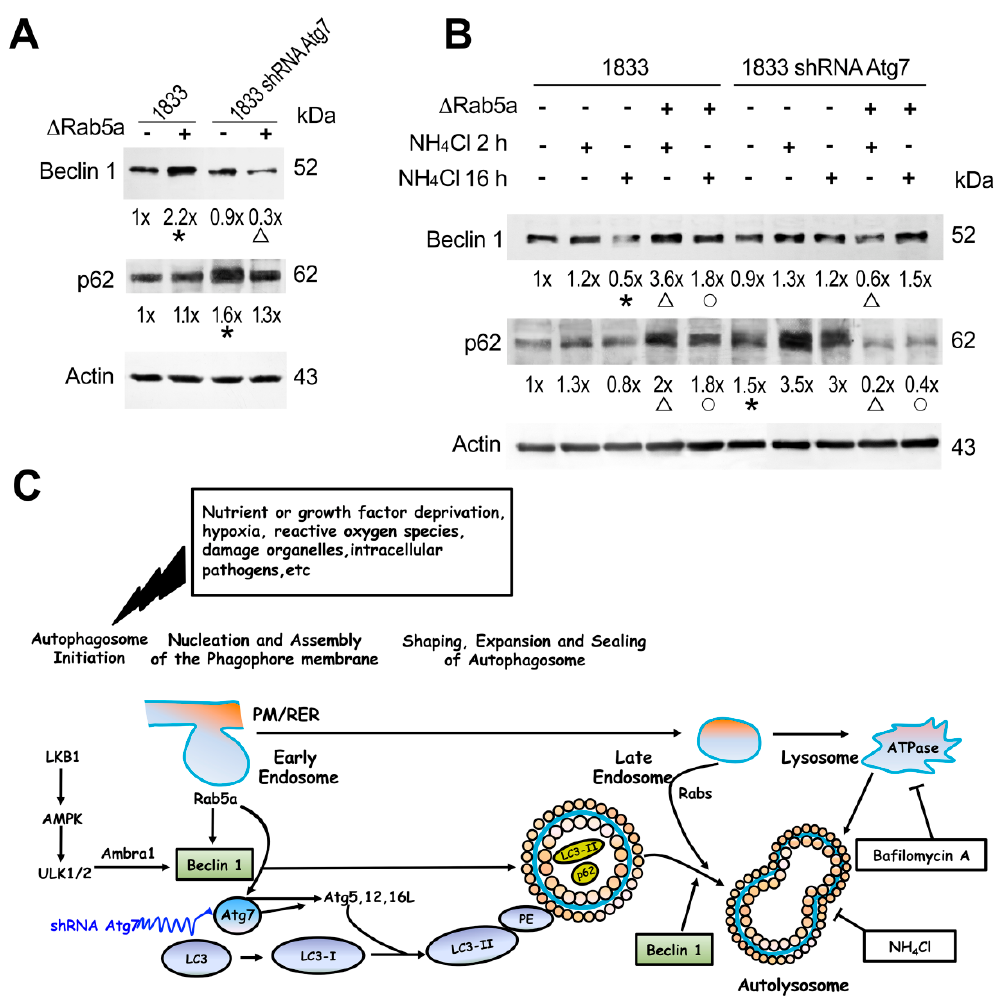
Figure 5. Effect of Δ Rab5a on Beclin 1 and p62 in 1833 and in 1833-shRNA Atg7 cells. ( A ) Samples of total protein extracts (100 µg) were analysed by Western blot. Actin was used for normalization. The experiments were repeated three times with similar results. * p < 0.05 versus 1833-untransfected cells; Δ p < 0.05 versus 1833-shRNA Atg7 cells; ( B ) Samples of total protein extracts (100 µg) were analysed by Western blot. Actin was used for normalization. The experiments were repeated three times with similar results. * p < 0.05 versus the first lane; Δ p < 0.05 and ° p < 0.05 versus cells exposed to NH 4 Cl for 2 and 16 h, respectively; ( C ) Schematic representation of the experimental approach and of the results obtained by us, in the context of autophagy triggering by a plethora of stimuli, which might be active in bone metastatic tissue, influencing basal autophagic process observed in the bone-metastatic 1833 cells.